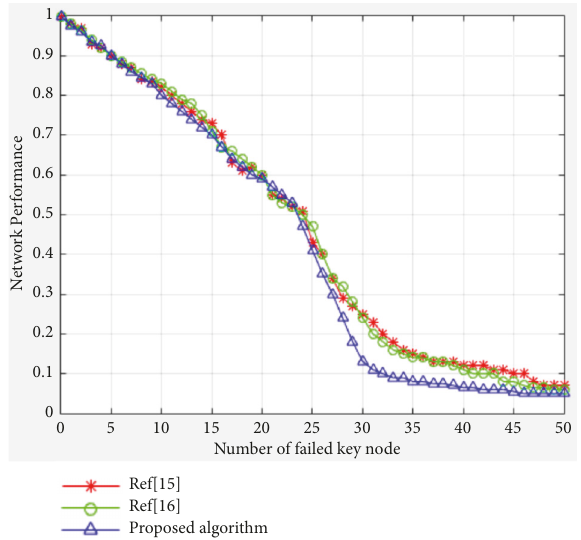
Figure 5: Comparison of Nanjing’s transportation network based on the three algorithms and the key node